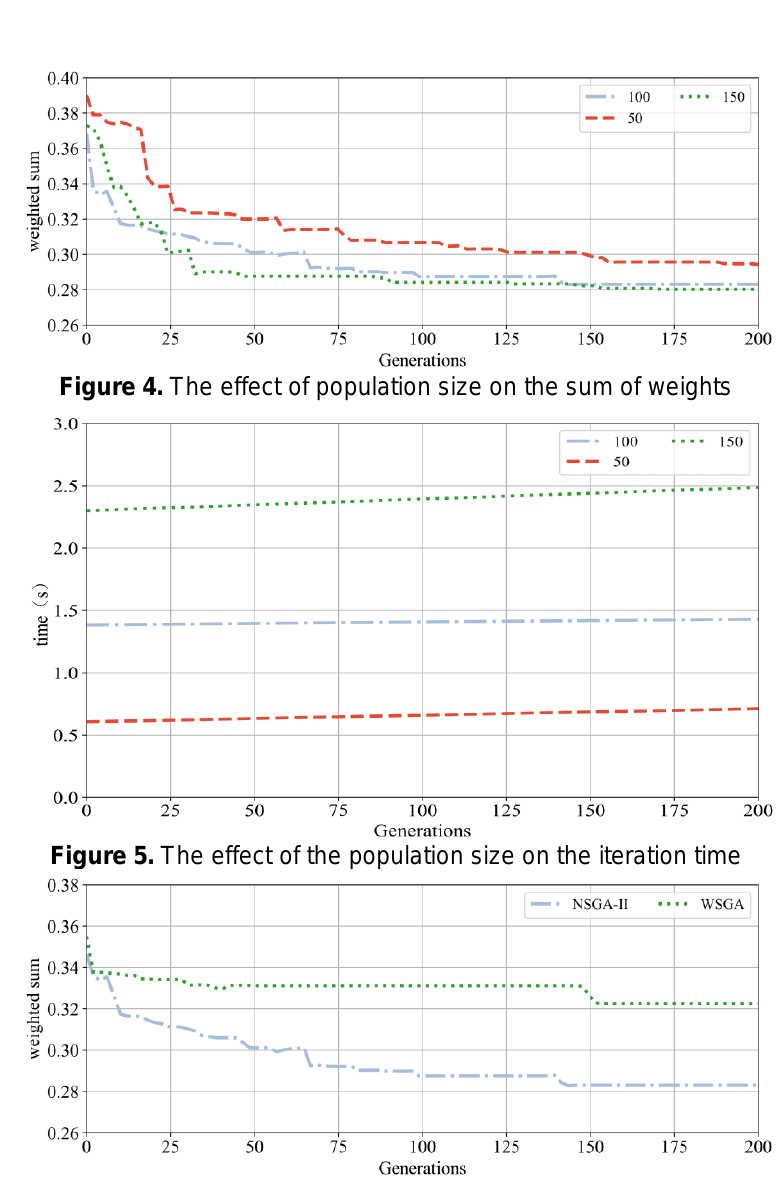
Figure 6 . Comparison of the weighted sum